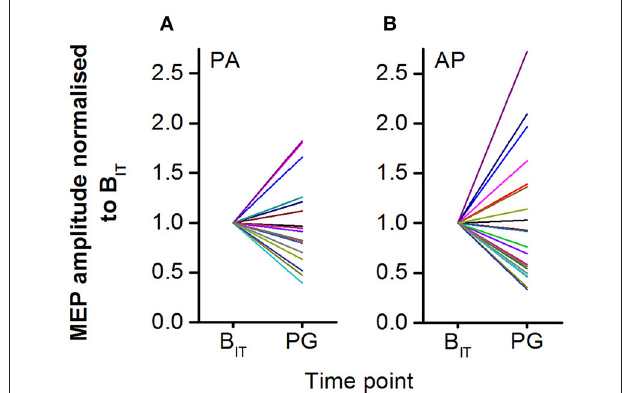
FIGURE 5 | Individual MEP amplitudes for PA (A) and AP (B) currents shown normalized to the intra-task baseline. MEP responses to action observation during the videos were highly variable across participants, with some showing strong facilitation and others showing strong